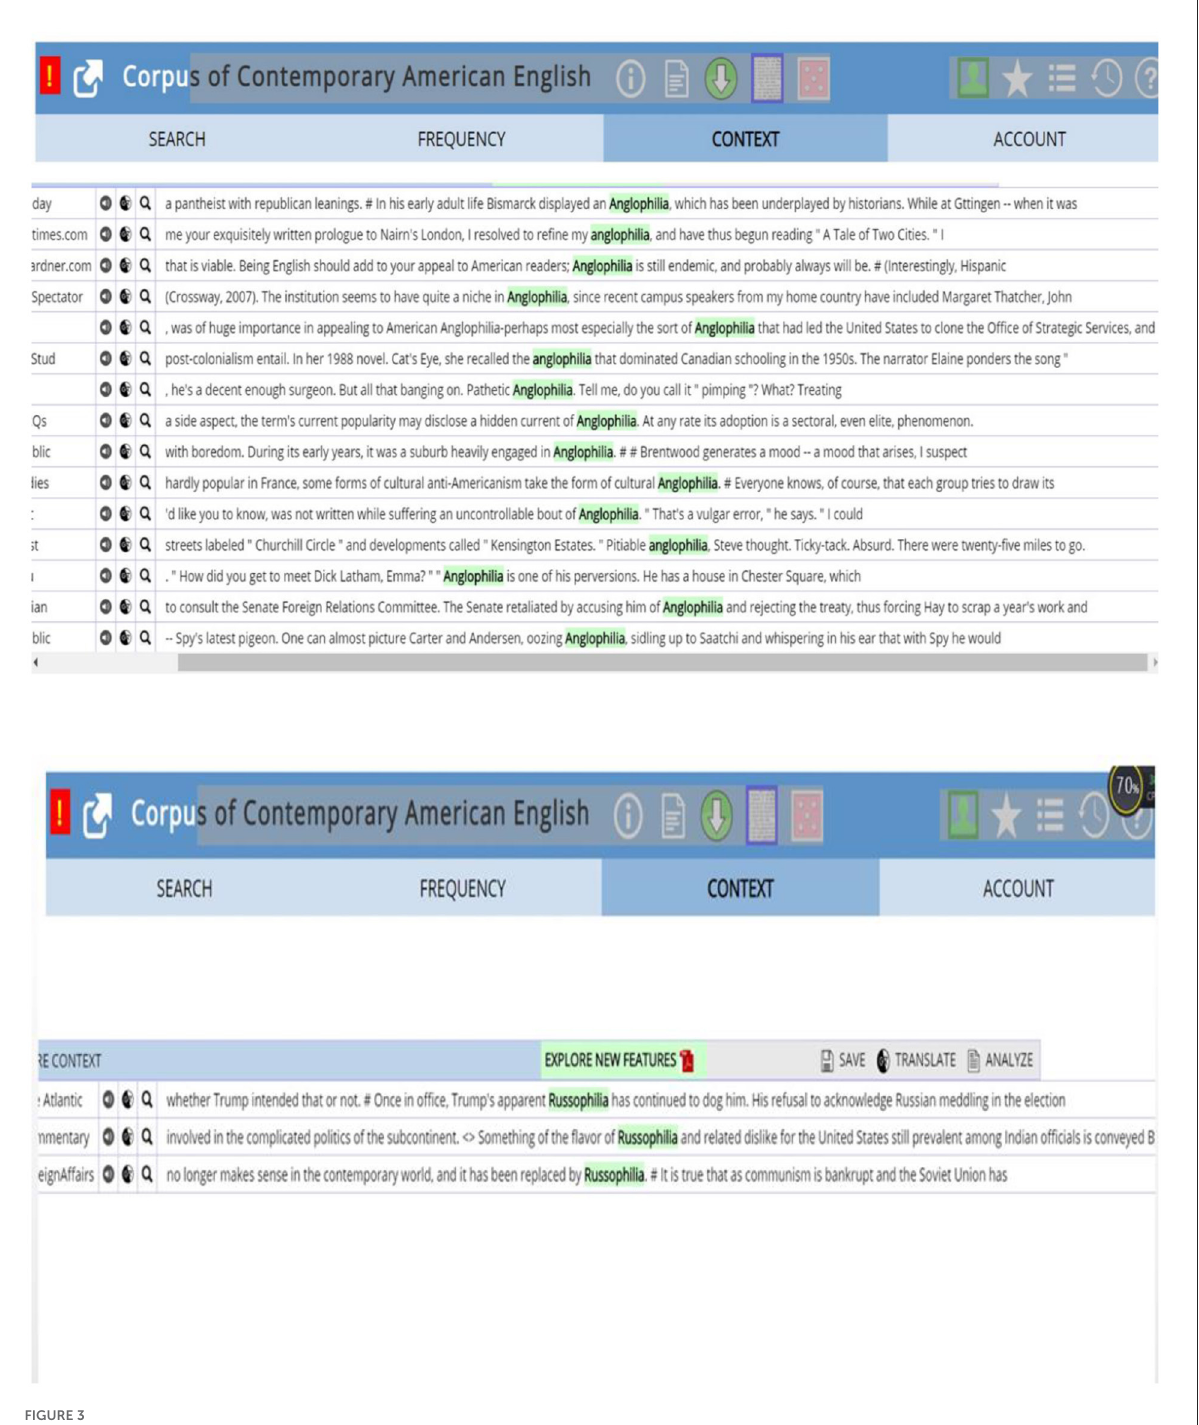
FIGURE3 Concordance lines of Anglophilia and